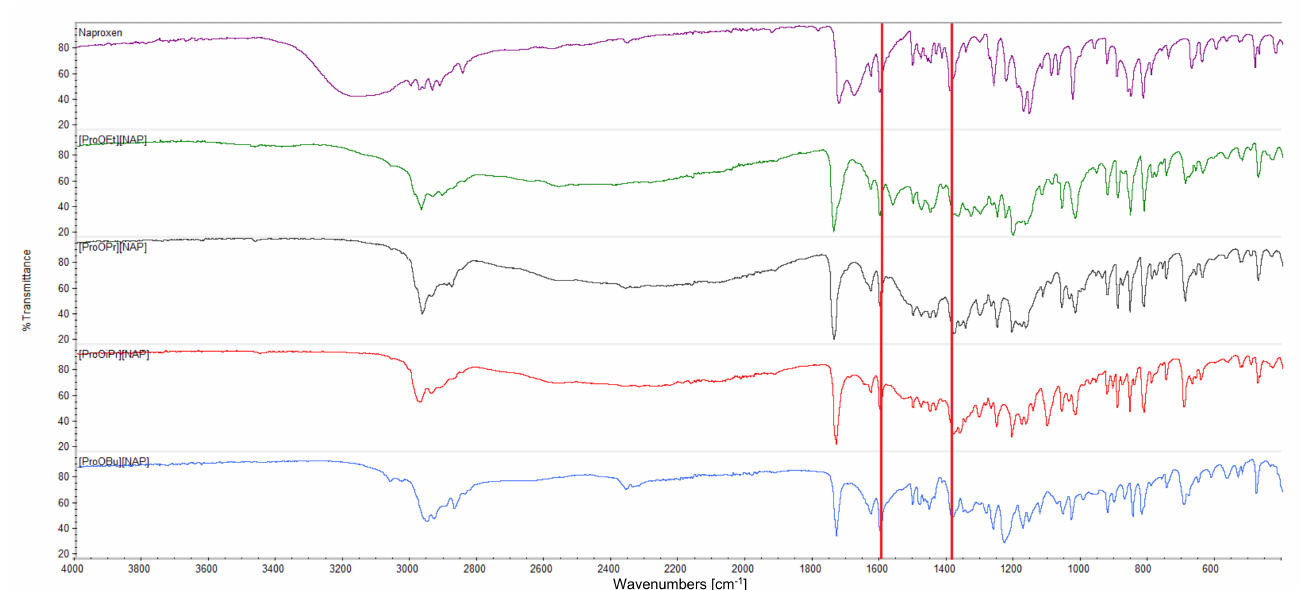
Figure 3. ATR-FTIR spectra for naproxen (purple), [ProOEt][NAP] (green), [ProOPr][NAP] (black), [ProOiPr][NAP] (red), [ProOBu][NAP] (blue) ( ν sym. ) (COO − ), and asymmetric ( ν asym. ) (COO − ) stretching vibrations marked in